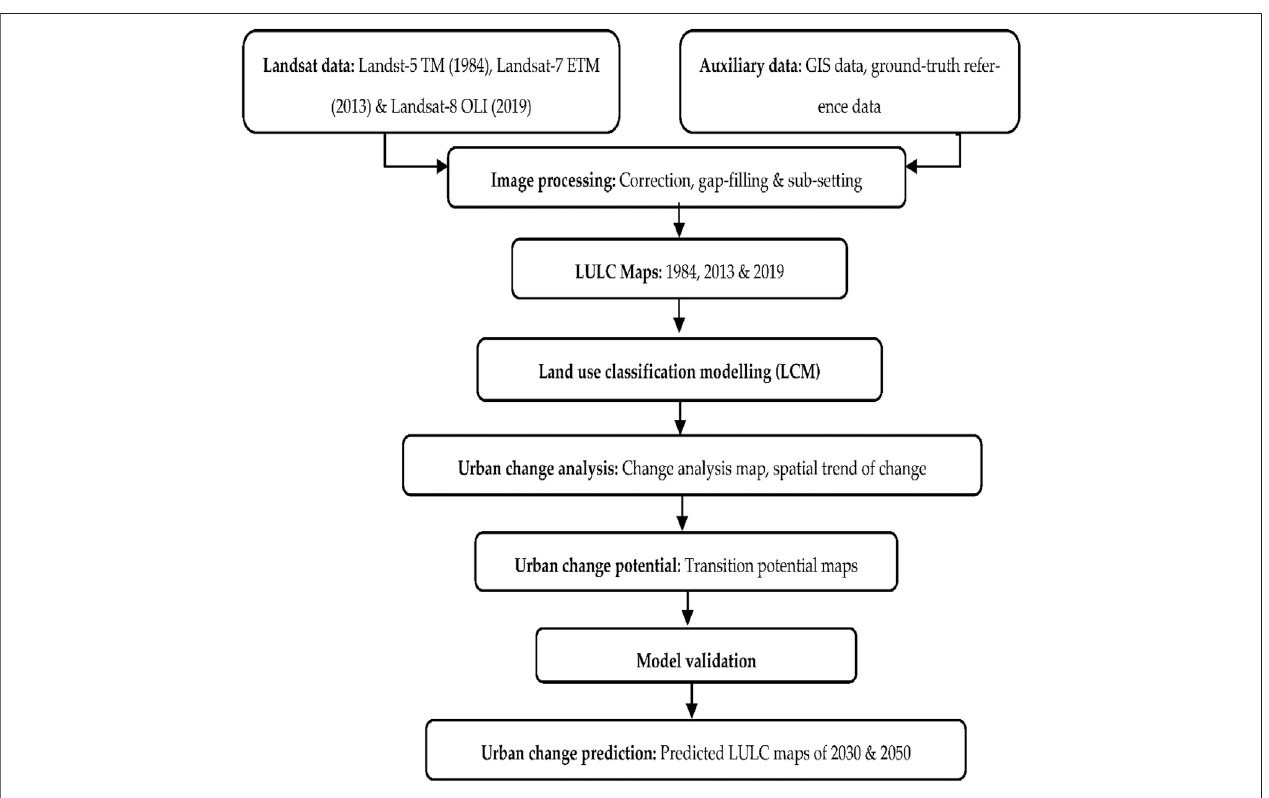
FIGURE 1 | Methodology of simulation of urban LULC change